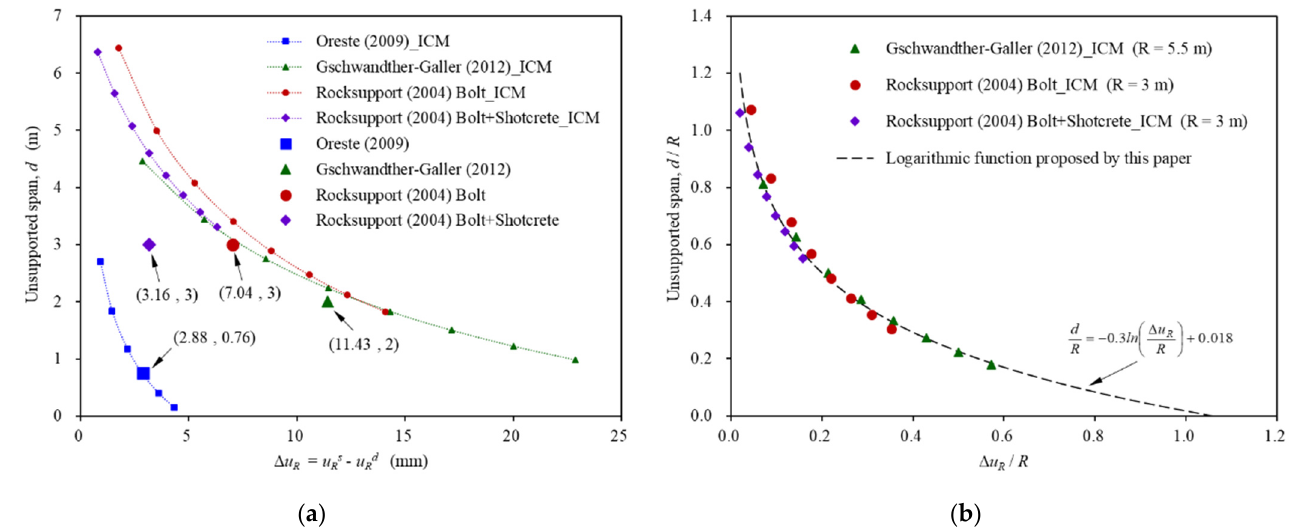
Figure 6. Estimation of the unsupported span ( d ) from the difference of the radial displacement between point C and point E in the inverse analysis (ICM). ( a ) The comparison with the original data, and ( b ) the description of the regression curve.